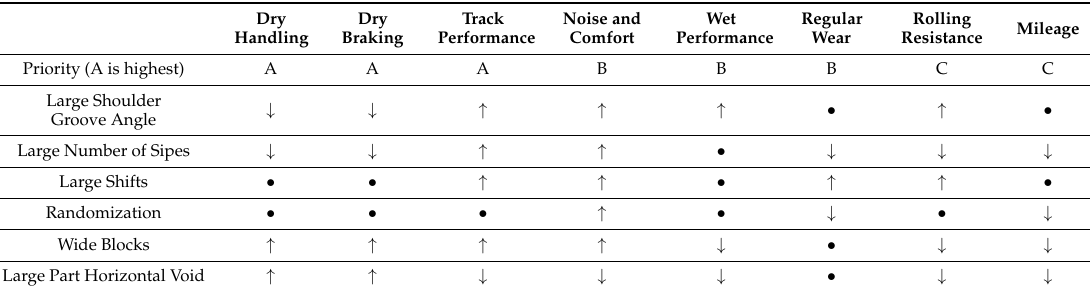
Table 8. Tread pattern design requirements (modified from Liljegren, 2008 [164], Figure 46) ( ↑